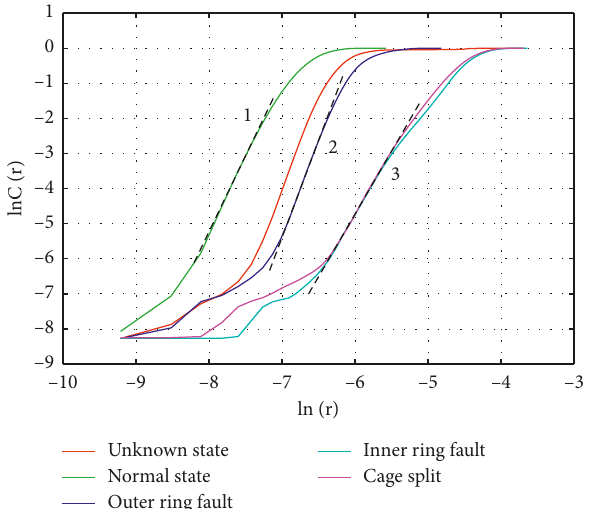
Figure 9: Fractal integral curve of